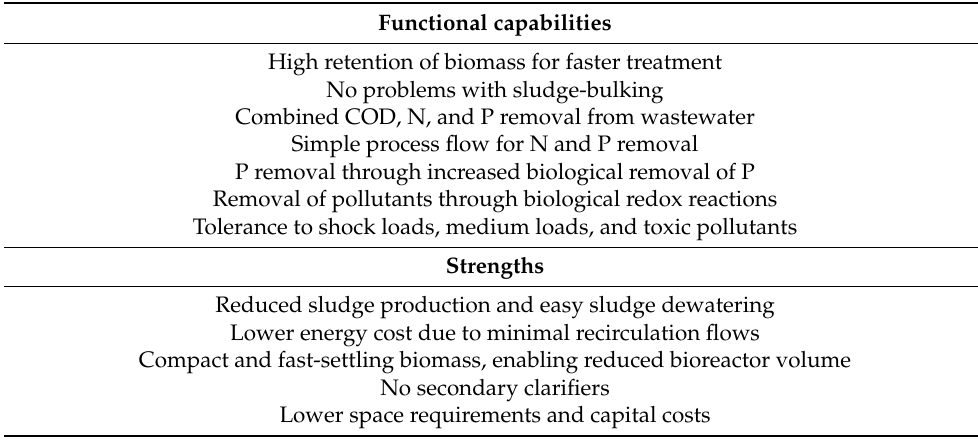
Table 2. Strengths and functional advantages of granular sludge technologies.